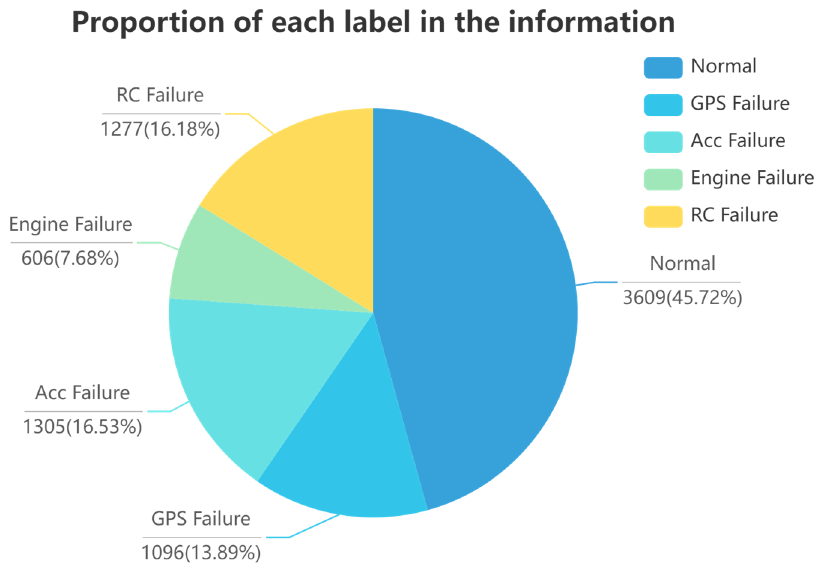
Table 8. Data distribution table of the data set after the balancing process.